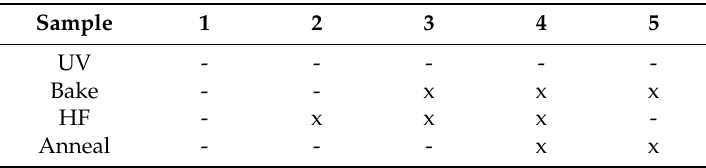
Table 1. Processing steps for APEX glass